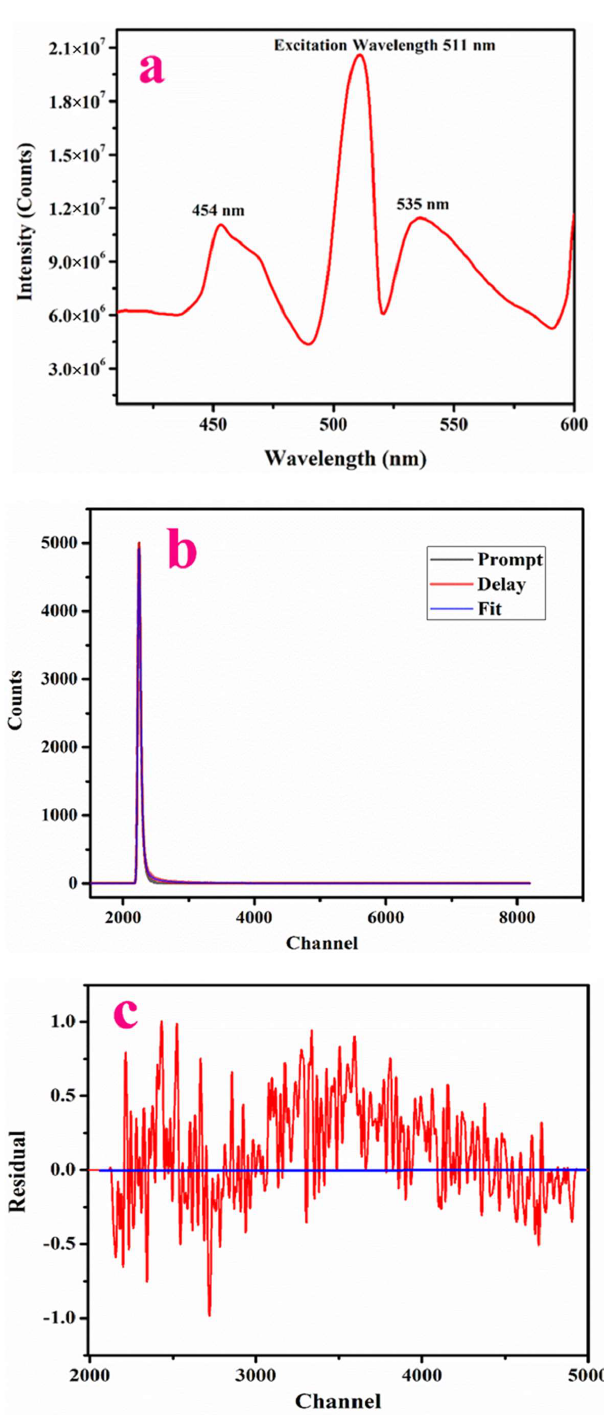
Figure 8. ( a ) Emission spectra of LPPMA; ( b ) Fluorescence life time spectra of LPPMA, ( c ) Residual Fit of LPPMA.